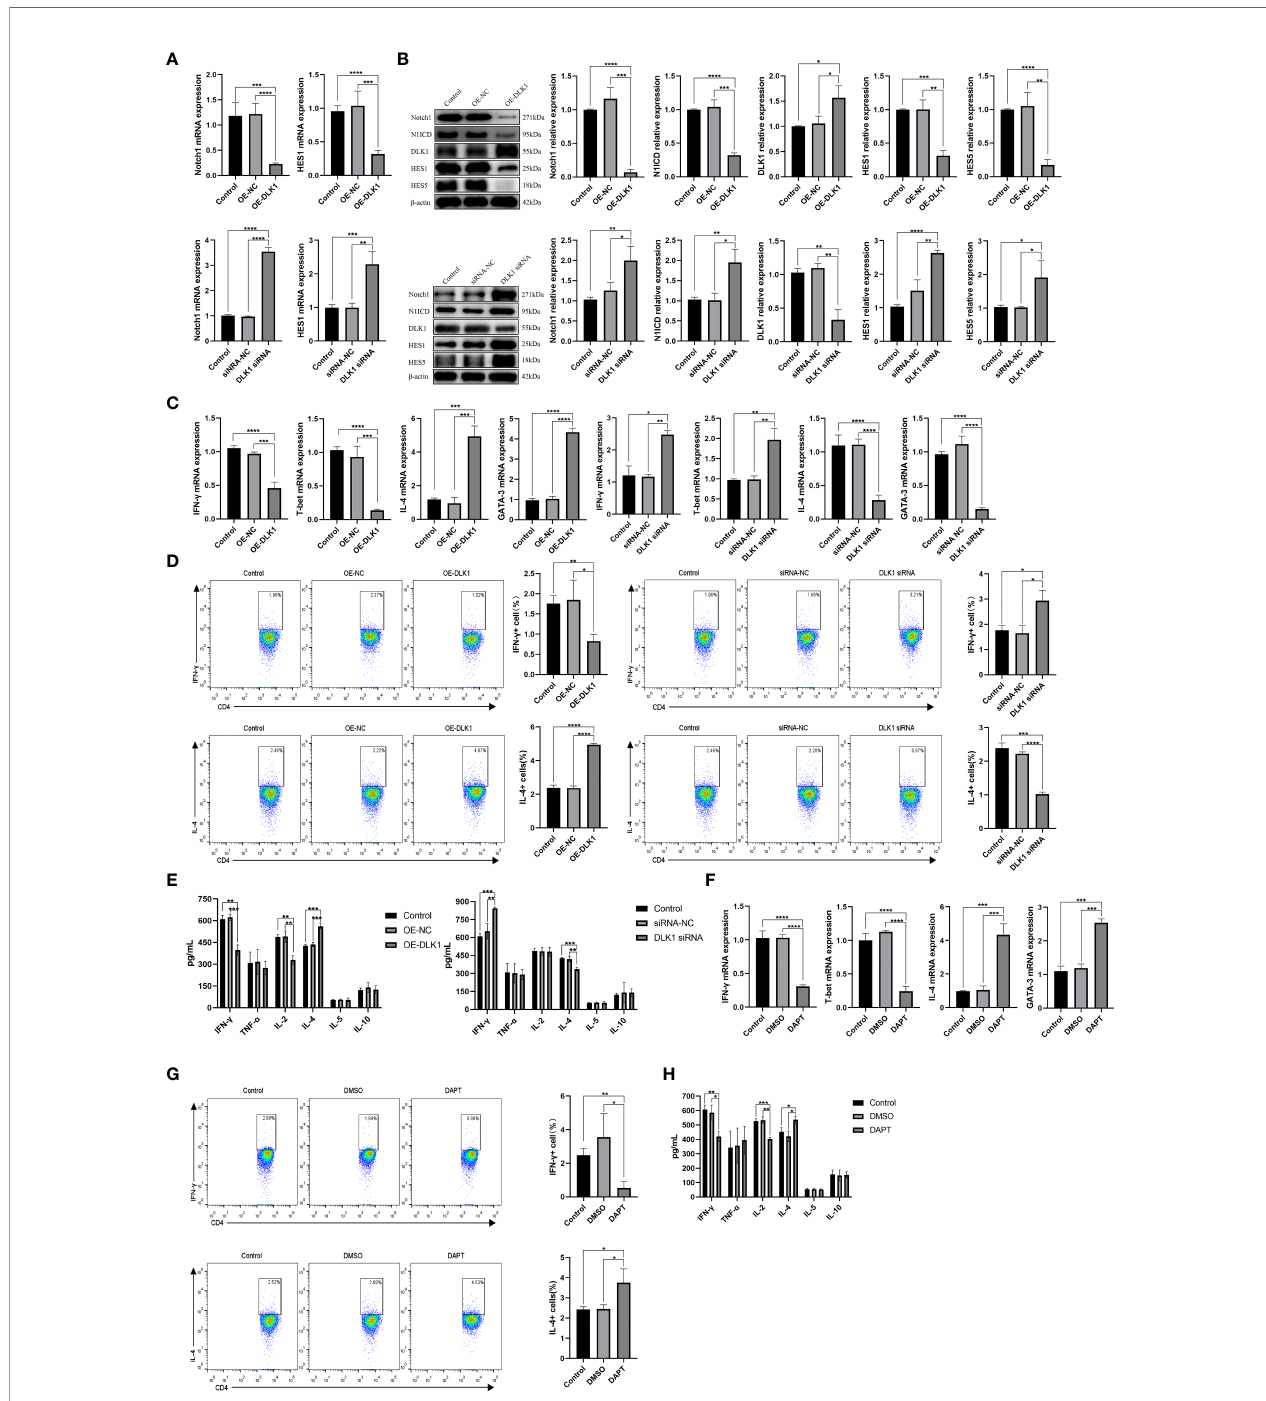
FIGURE 4 | DLK1 modulates naive CD4 + T-cell differentiation through the Notch1 signaling pathway. (A) Notch1 and HES1 mRNA expression after transfection with OE-DLK1 or DLK1 siRNA in naive CD4 + T cells determined by qRT-PCR. (B) The protein expression of Notch1, N1ICD, DLK1, HES1, and HES5 after transfection with OE-DLK1 or DLK1 siRNA in naive CD4 + T cells by Western blot. (C) qRT-PCR detection of mRNA expression of IFN- g , T-bet, IL-4, and GATA-3 after transfection with OE-DLK1 or DLK1 siRNA in naive CD4 + T cells. (D) Expression of IFN- g and IL-4 after transfection with OE-DLK1 or DLK1 siRNA in naive CD4 + T cells determined by fl ow cytometry. (E) The expression of IFN- g , TNF- a , IL-2, IL-4, IL-5, and IL-10 after transfection with OE-DLK1 or DLK1 siRNA in naive CD4 + T cells measured by ELISA. (F) qRT-PCR detection of mRNA expression of IFN- g , T-bet, IL-4, and GATA-3 after transfection with DAPT in naive CD4 + T cells. (G) Expression of IFN- g and IL-4 after transfection with DAPT in naive CD4 + T cells determined by fl ow cytometry. (H) The expression of IFN- g , TNF- a , IL-2, IL-4, IL-5, and IL-10 after transfection with DAPT in naive CD4 + T cells measured by ELISA. * P < 0.05, ** P < 0.01, *** P < 0.001, **** P <